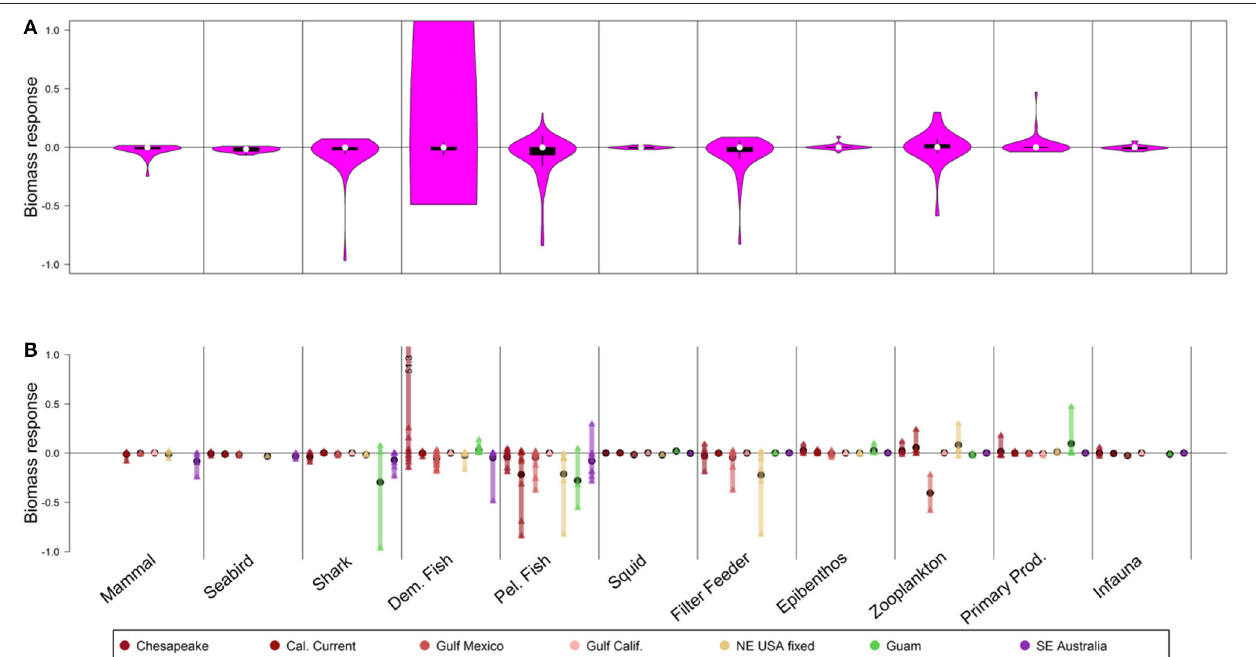
FIGURE 4 | Biomass response to 50-year scenarios with 2 × fishing mortality on small pelagic fish. Panel explanations as in Figure 2 .